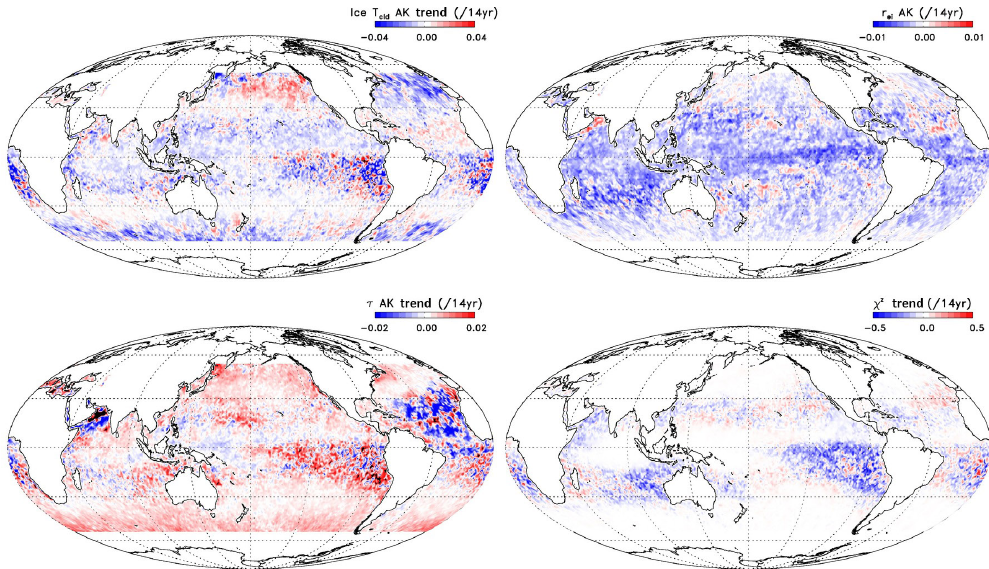
Figure 4. The global 14-year trends for the fields in Fig. 2. Note that the minimum and maximum trends may exceed those indicated in the colour bar.